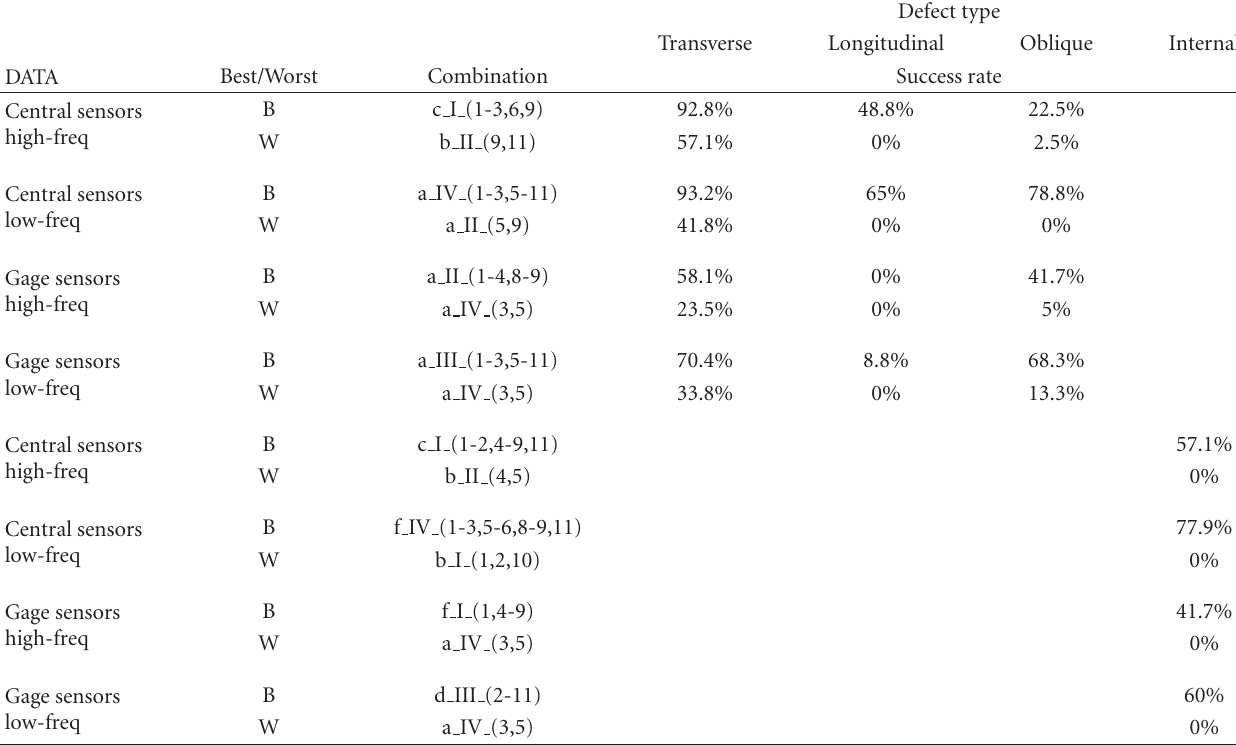
Table 3: Test 1. Multivariate analysis: percentage of outliers for various transducer pairs, frequency bandwidths, and damage types. The best and the worst combination of wavelet processing and damage index features are